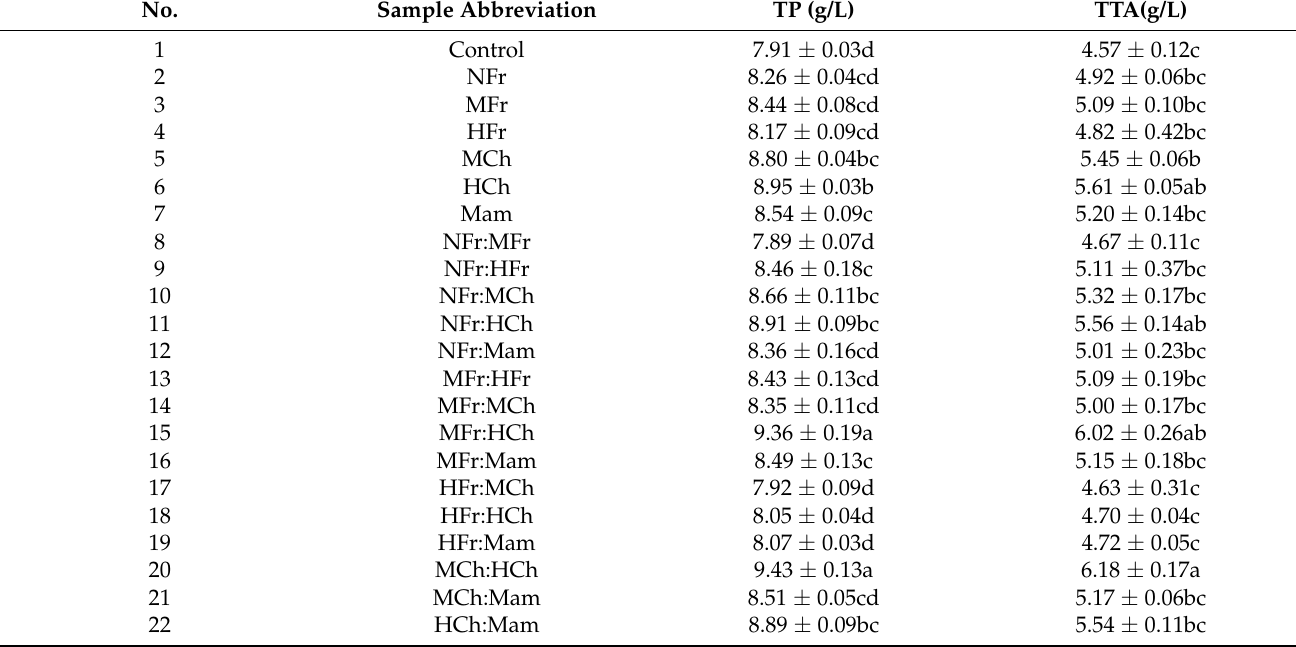
Table 3. Total polyphenols and total tannins of wines of Vitis